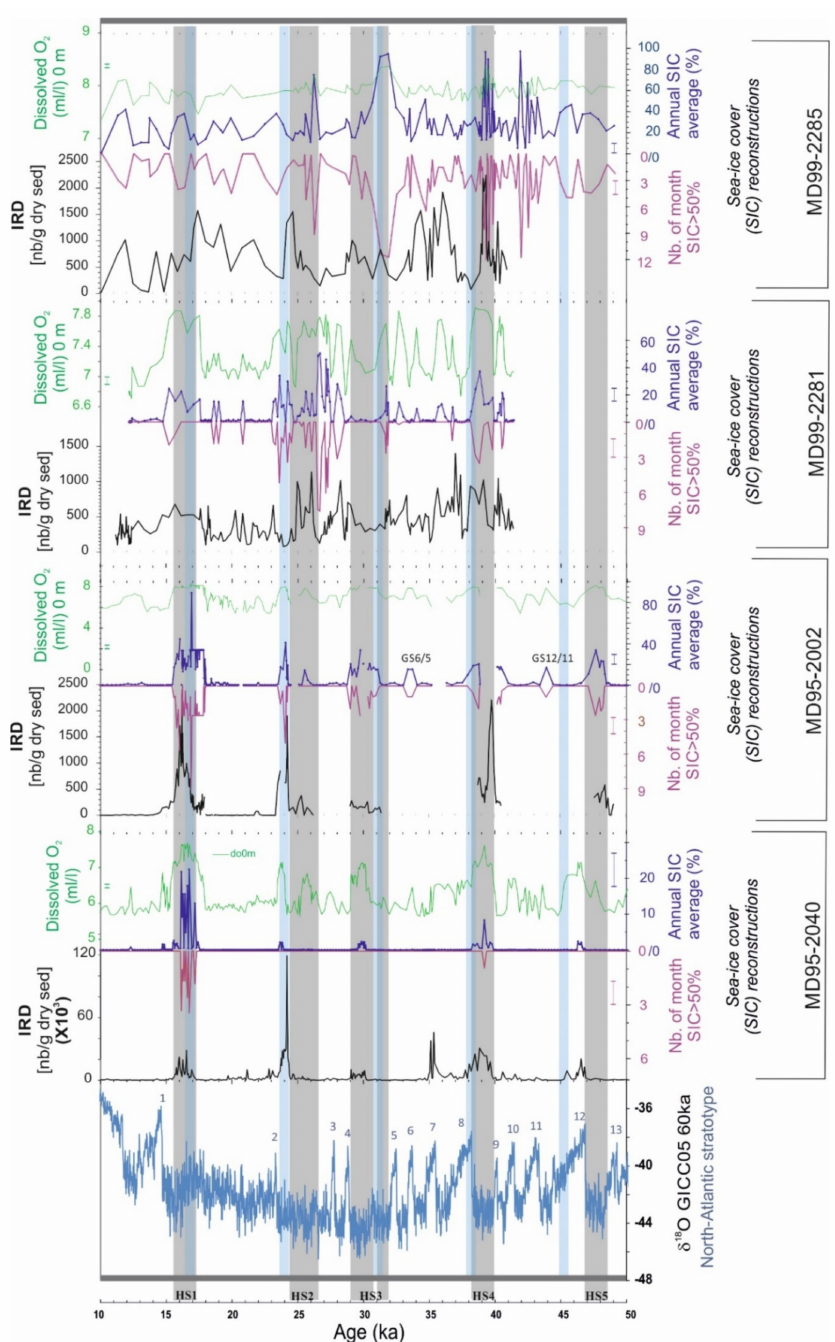
Figure 5. Comparison along the 50–10 ka interval of data linked to the ice advection or dynamics at the sites under examination. Reconstructed dissolved oxygen concentrations ( do ) at the surface were added for each core to check the effect of ice cover on the ventilation of the sea-surface ocean during HEs. The North Atlantic stratotypical reference (i.e., NGRIP δ 18 O [46]) is also plotted; the stratigraphical positions of the main cold events as documented in previous Figures are also represented by vertical bands. For color used in this figure, the reader is referred to the Web version of this